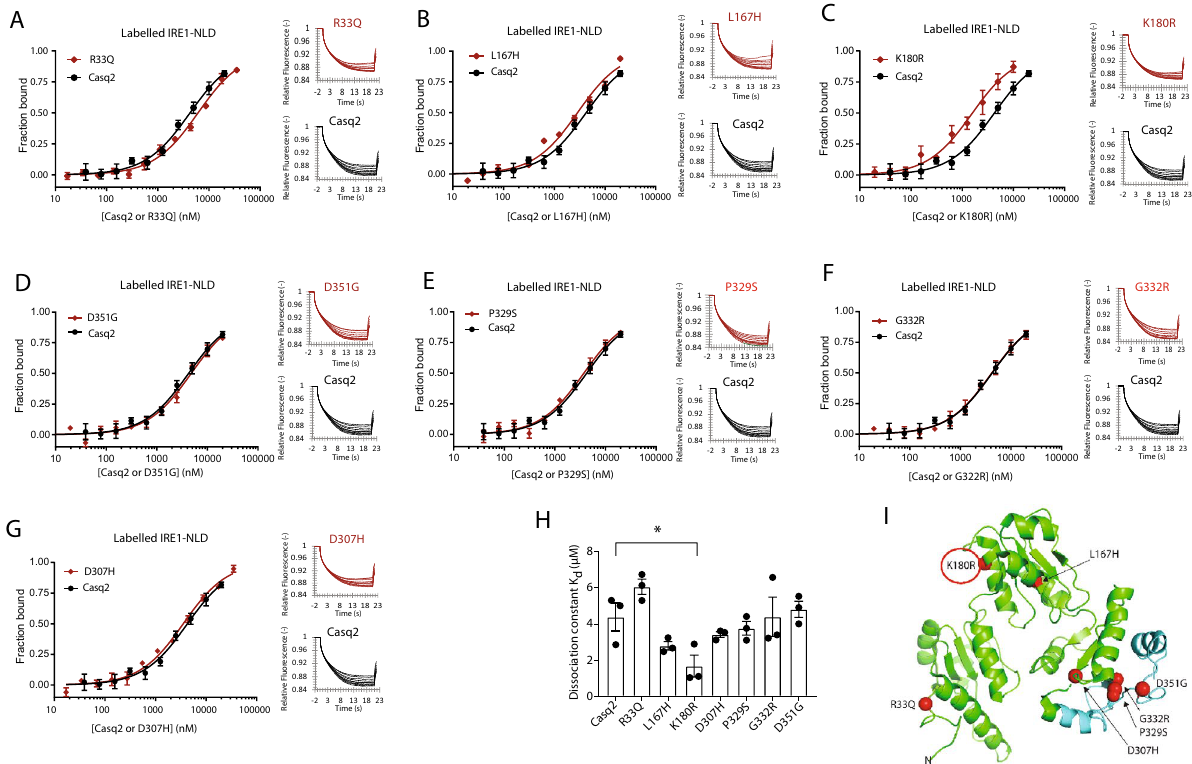
Figure 9. Casq2 mutants binding to the ER luminal domain of IRE1α. ( A – G ) Recombinant N-terminus luminal domain of IRE1α (IRE1-NLD) protein was covalently labeled with a red fluorescent tag and incubated with increasing amounts of Casq2 or Casq2 mutant as indicated in the Figure. Normalized MST time traces are shown to the right of the graph. Each data point is the average of three independent microscale thermophoresis measurements. ( H ) Bar graph depicts dissociation constants for different Casq2 mutants. *p = 0.05. ( I ) Human Casq2 crystal structure (2VAF). The red circle on the Casq2 3D structure depicts the location of mutation with altered IRE1-NLD